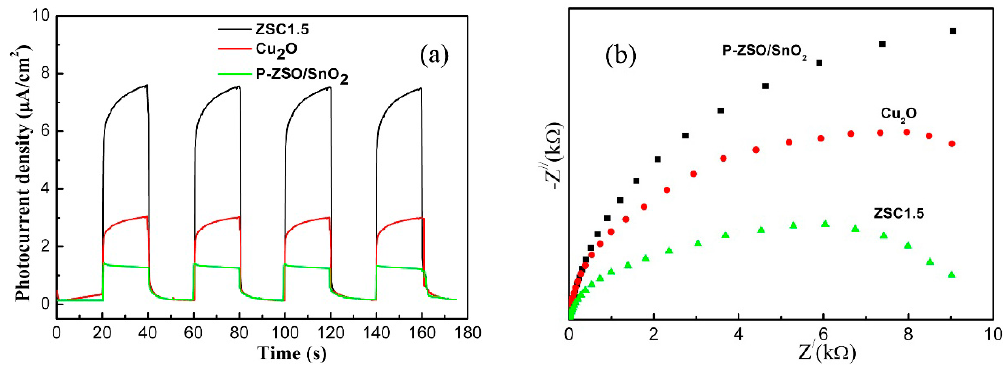
Figure 8. Transient photocurrents ( a ) and Electrochemical impedance spectra ( b ) of P-ZSO/SnO 2 , Cu 2 O, and ZSC hybrids electrodes under visible light irradiation ( λ > 420 nm).